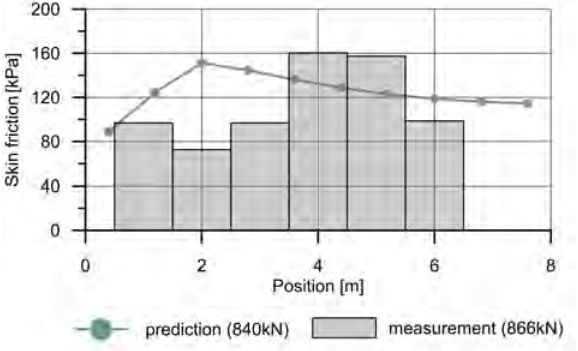
Figure 15. Comparison of shear stress distribution for last loading